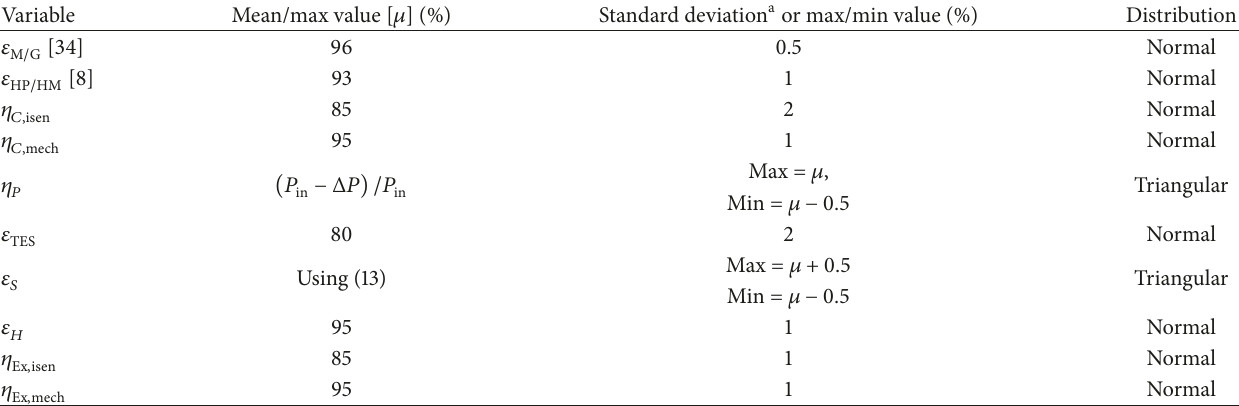
Table 1: Stochastic assignments in Monte Carlo simulation.